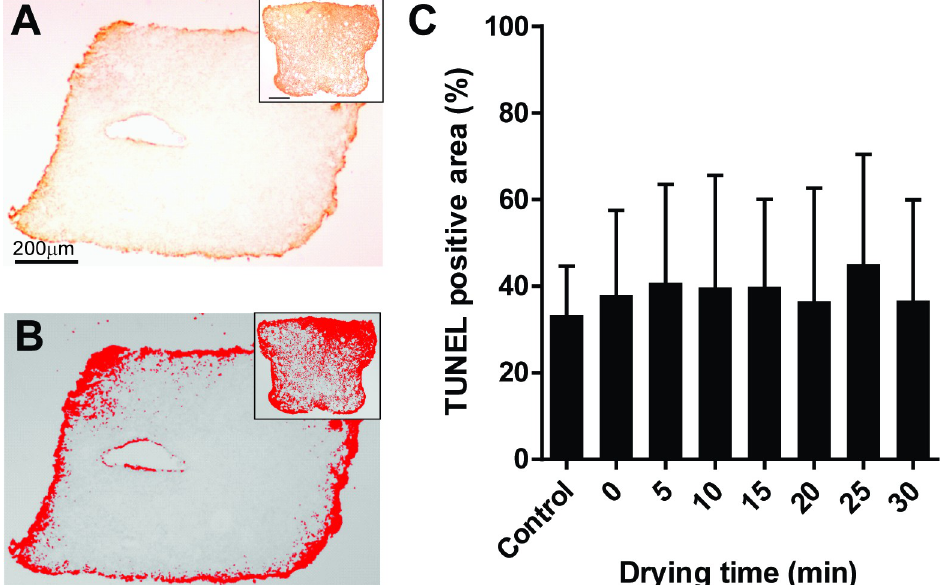
Fig 6. Effect of drying time on DNA integrity. (A) Representation of TUNEL-positive staining (brown) indicating DNA damage in the cortical piece. Inset: DNase-treated positive control tissue. Scale bars = 200 μ m. (B) Quantification of TUNEL-positive area using ImageJ. Inset: DNase-treated positive control tissue. (C) Analysis of DNA integrity of tissue pieces dried for up to 30 min. Values are mean ± SD. No statistically significant ( P > 0.05) differences were